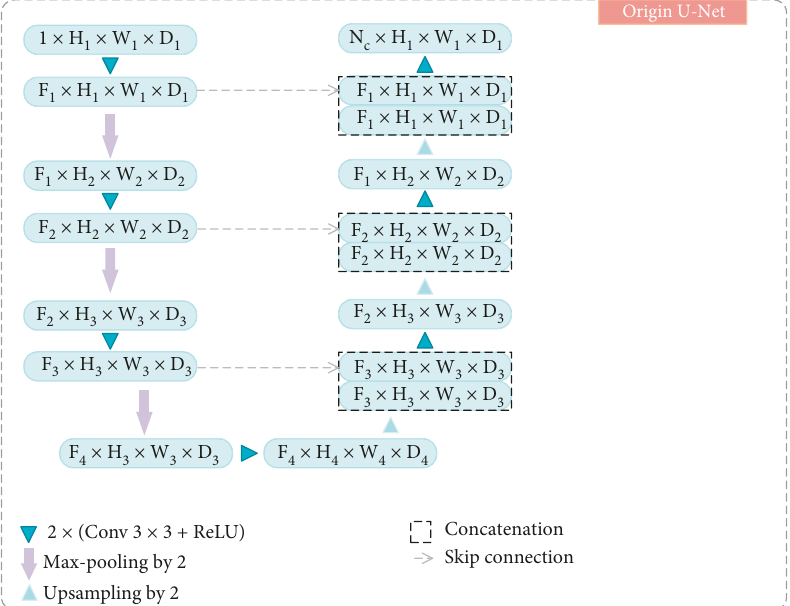
Figure 1: Basic framework of U-Net.